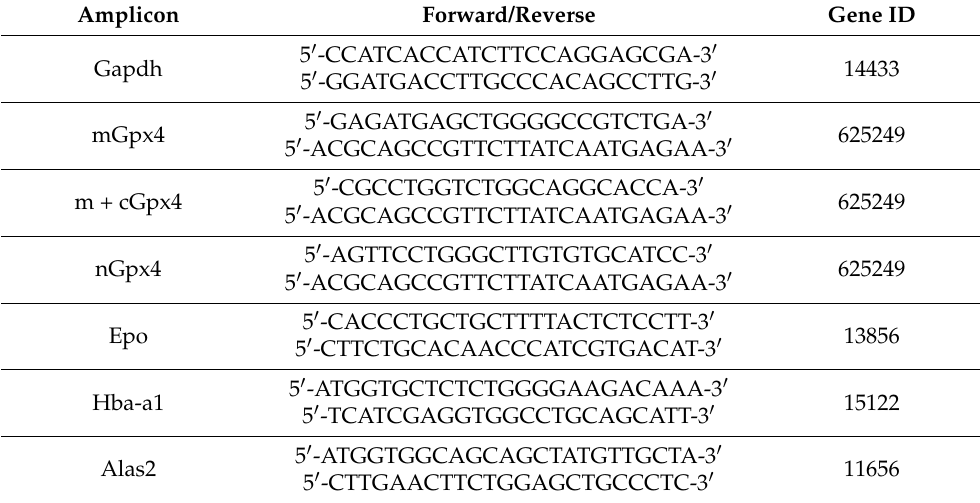
Table 1. Primer sets used for quantitative real-time